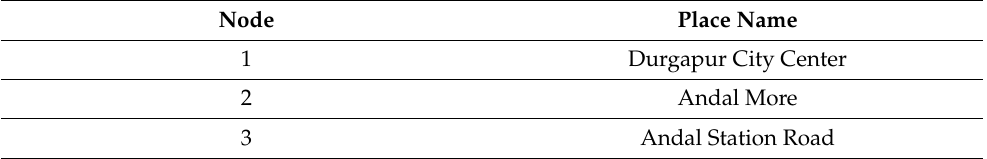
Table 5. Description of node. Node Place Name 1 Durgapur City Center 2 Andal More 3 Andal Station